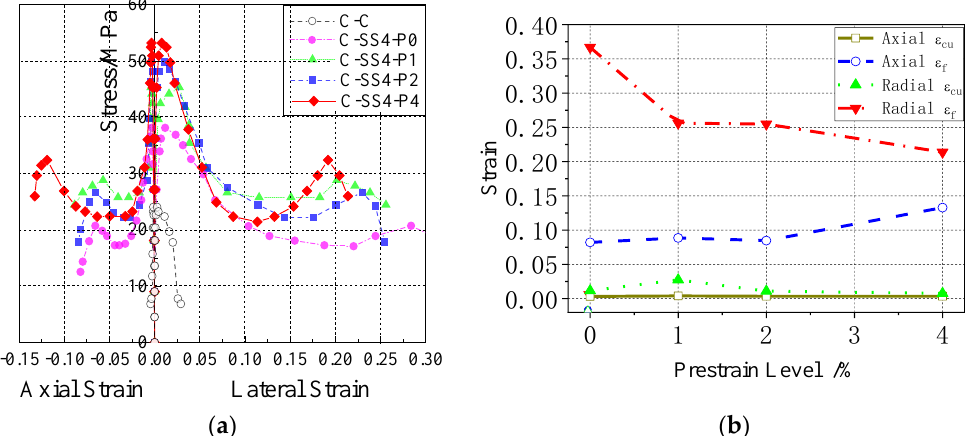
Figure 9. Axial and lateral stress–strain relation comparison of SMA wire reinforced concrete cylinders with different prestrain levels: ( a ) Axial and radial stress-strain curves of SMA reinforced concrete cylinders with different prestrain levels; ( b ) Comparison of axial and lateral peak strain and failure strain of concrete cylinders with different prestrain levels.